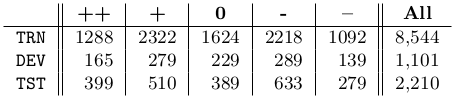
Table from the paper: Lexicon Integrated CNN Models with Attention for Sentiment Analysis
Table text:
++
+
0
-
–
All
TRN
1288
2322
1624
2218
1092
8,544
DEV
165
279
229
289
139
1,101
TST
399
510
389
633
279
2,210